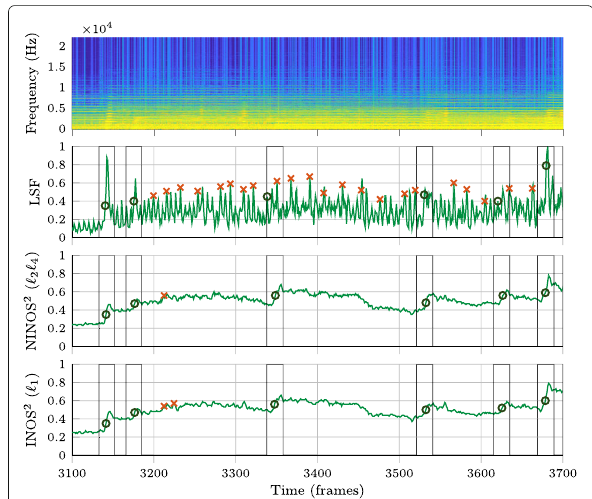
Fig. 8 Comparison of ODFs and peak-picking results for trumpet (Bach) excerpt. Vertical lines represent onset detection windows indicating ground-truth onsets. Circles are used to mark true positives in the peak-picking results, while false positives are marked with crosses